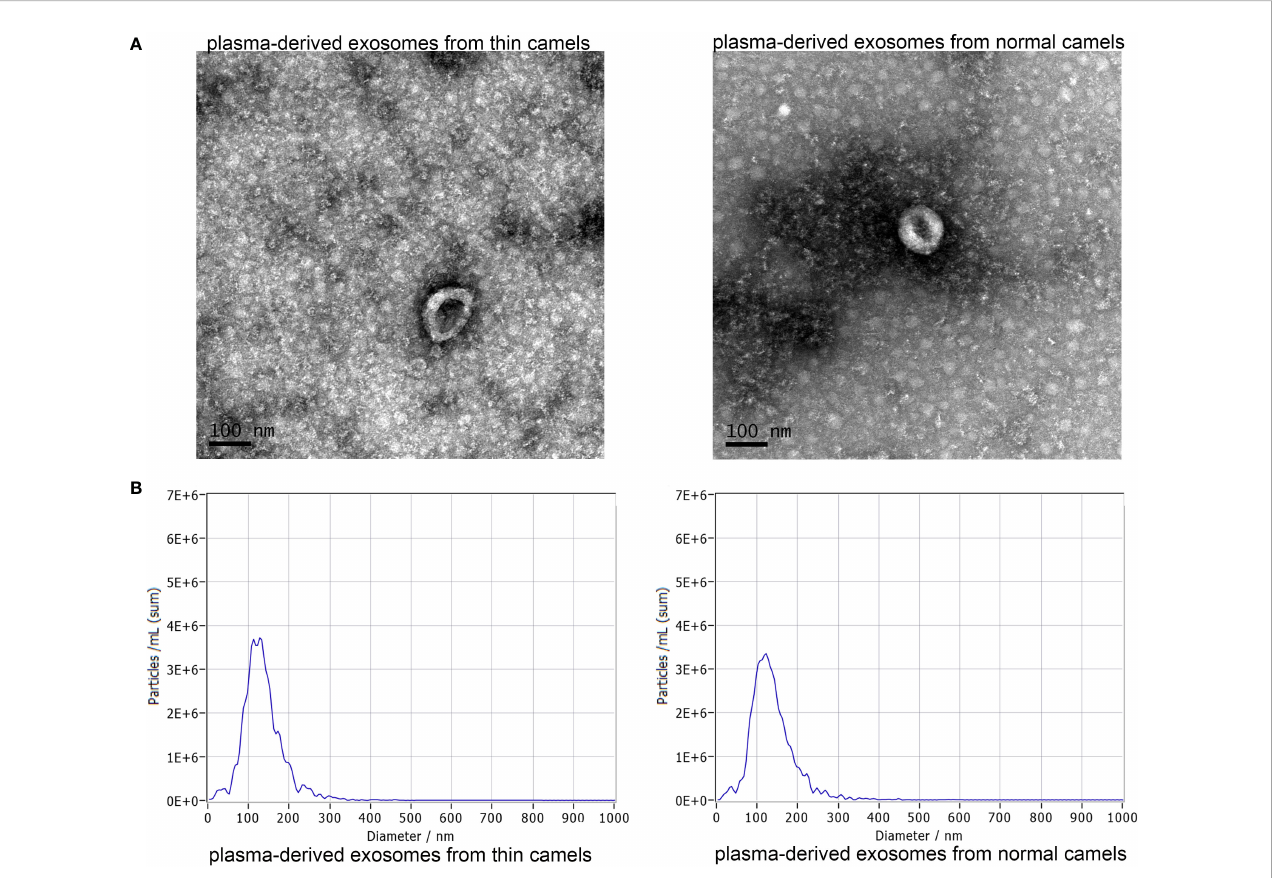
FIGURE 1 Characterization of exosomes from the plasma of thin Bactrian camels and normal Bactrian camels. (A) The morphology of the two exosomes visualized using a transmission electron microscopy. scale bar = 100 nm. (B) A Nano particle tracking analyzer used to measure the exosomes size distributions. Left: plasma-derived exosomes from thin camels; right: plasma-derived exosomes from normal